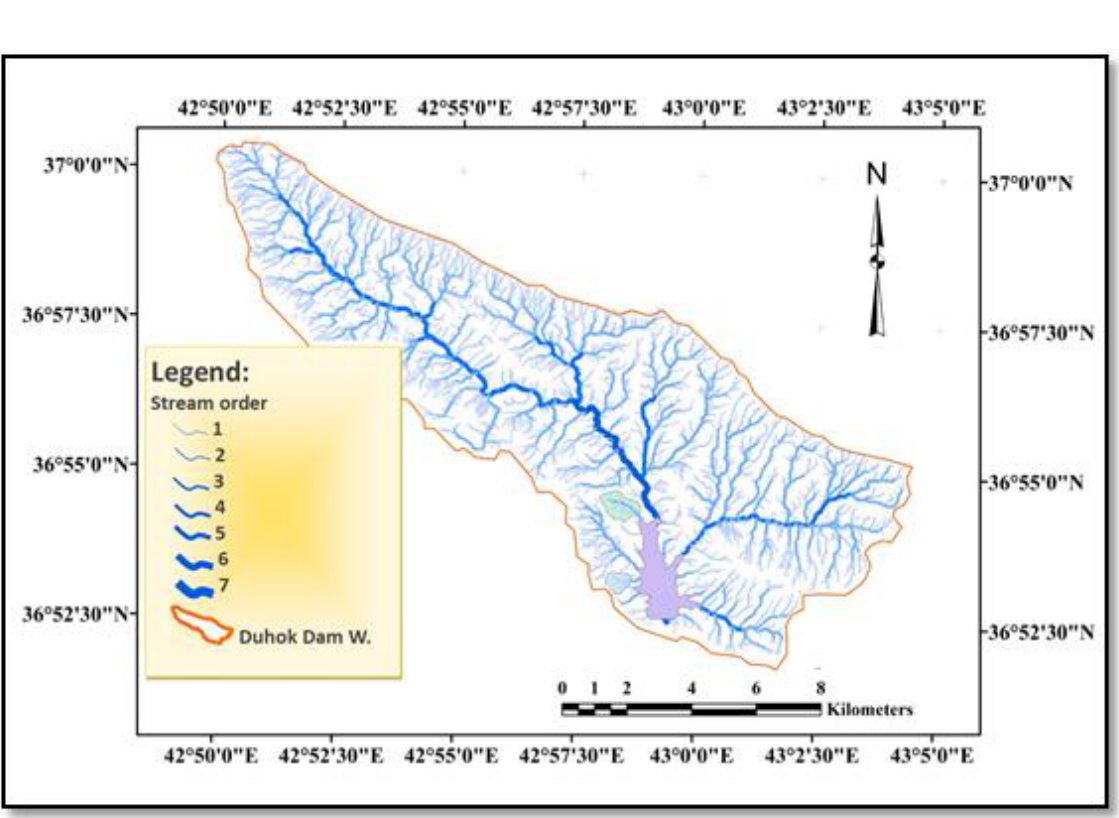
Figure 4. Duhok dam and its stream (Drainage